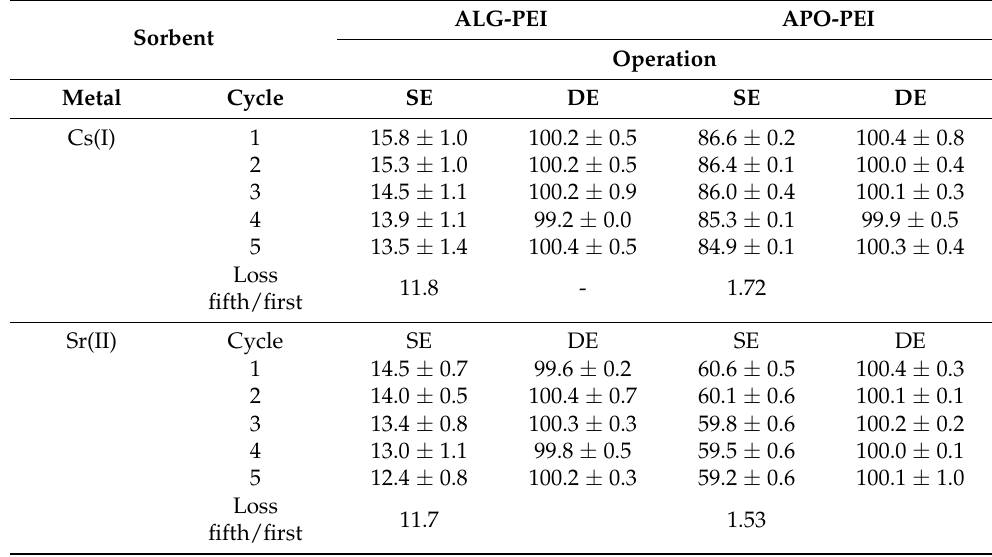
Table 3. Sorbent reuse: sorption (SE, %) and desorption (DE, %) efficiencies for five successive cycles. Sorbent